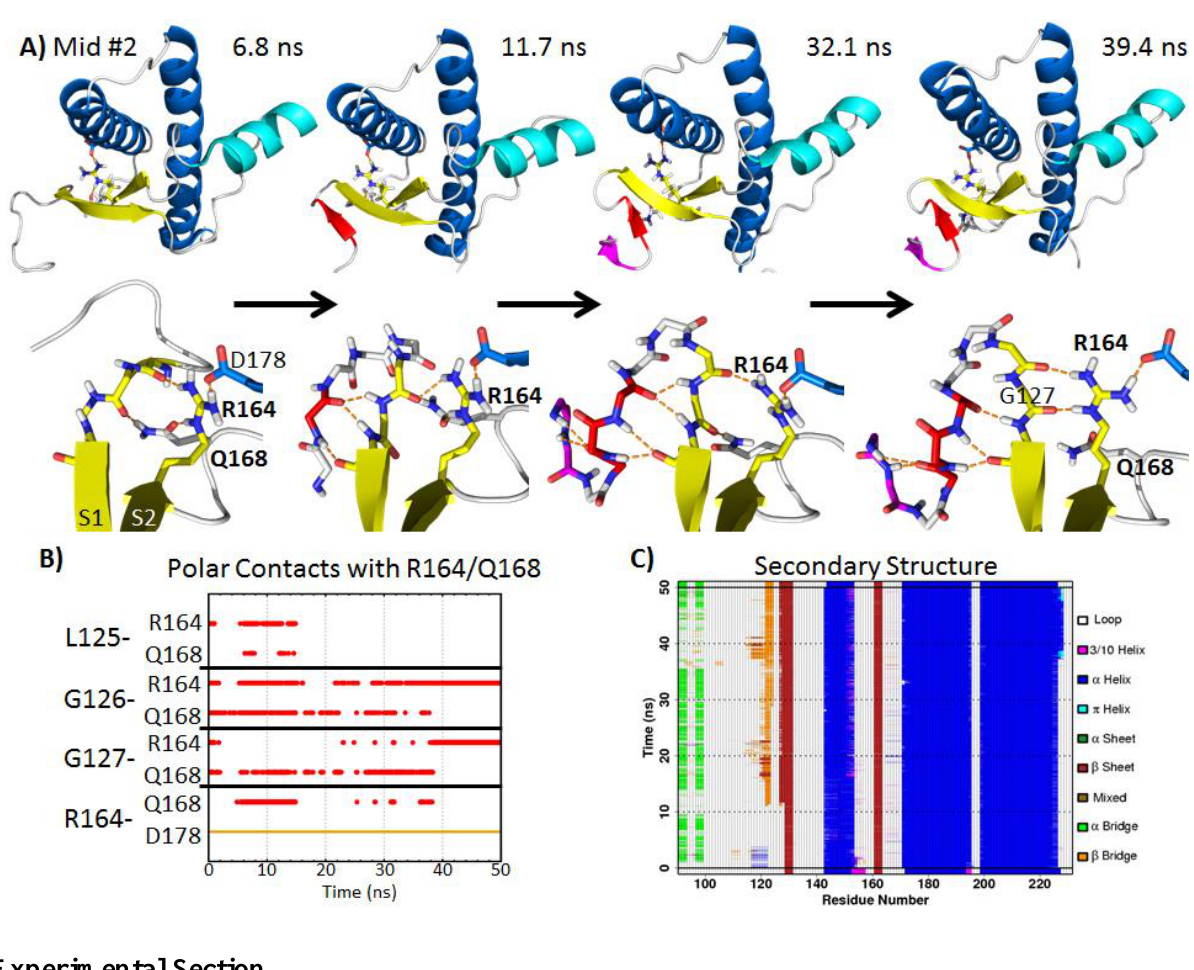
Figure 7. Illustration of nonnative strand formation at the N -terminus facilitated by N -terminal polar contacts with side chains of R164 and Q168 in mid-pH Simulation 2. (A) The top panel shows the PrP construct with the nonnative strands colored in red and magenta. Side chains of R164, Q168 and D178 are shown as sticks. The lower panel shows the close-up view of R164, Q168 and relevant N -terminal residues. (B) Hydrogen bonds and salt bridge formed with R164 or Q168 over time. (C) Analysis of PrP secondary structure, where orange and red regions indicate β-structures. A nonnative strand was formed from ~11.7–50